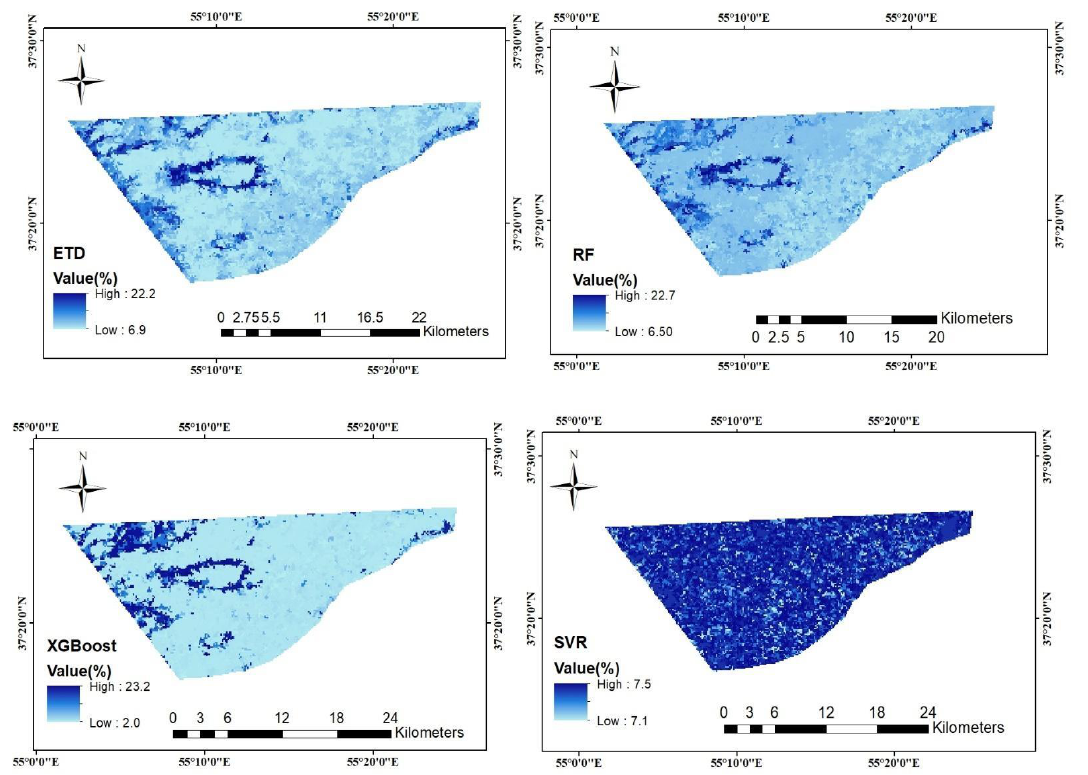
Figure 8. SMC map using Landsat with RF, XGBoost, SVR, and ETD.